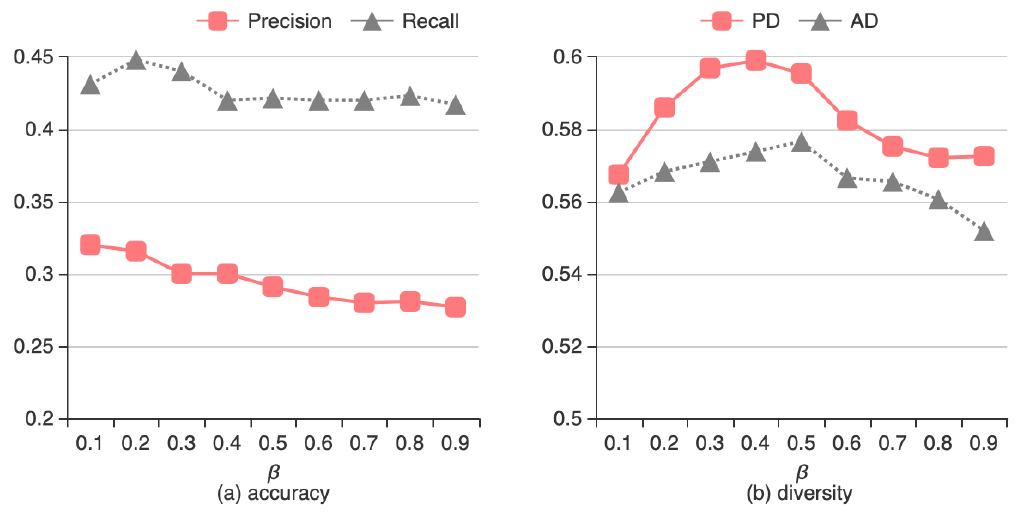
Figure 4. Effect of ranking strategy threshold β on ( a ) accuracy and ( b ) diversity of DBTS. Figure 4. E ff ect of ranking strategy threshold β on ( a ) accuracy and ( b ) diversity of